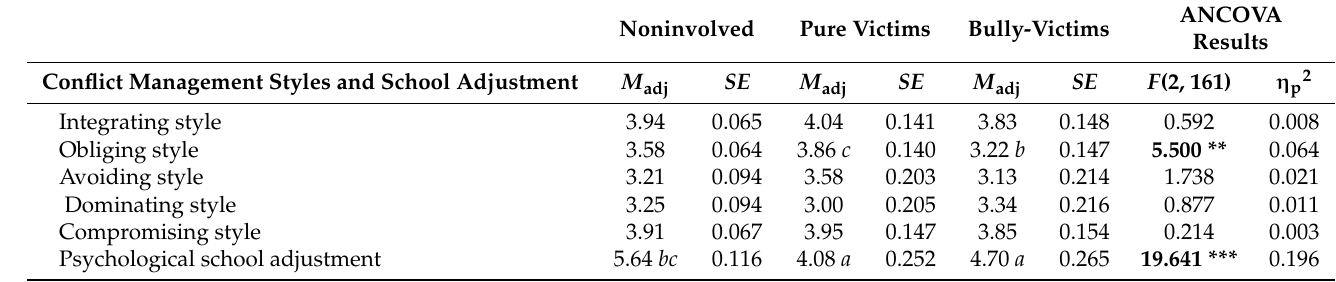
Table 5. ANCOVA Results: Adjusted Means and Standard Errors in Person-Oriented Bullying- Related Groups Regarding Conflict Management Styles and Psychological Adjustment in School.